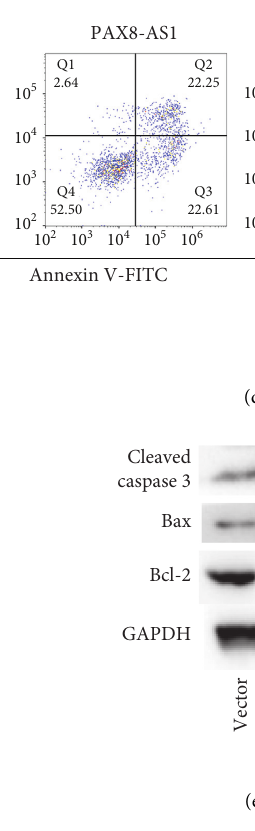
Figure 6: Interference with PKN2 reverses the effect of overexpression of PAX8-AS1 on cell proliferation and apoptosis. Note. (a) The expression of PKN2 in PTC K1 cells in vector, PAX8-AS1, and PAX8-AS1+sh-PKN2 groups was detected by qRT-PCR and western blotting; (b) the optical density values at 490nm at 24, 48, and 72 h in PTC K1 cells in the above three groups were detected by MTT assay; (c) cell proliferation of PTC K1 cells in the above three groups was examined by EdU assay; (d) flow cytometry was used to analyze the scatter patterns of cell cycle distribution of K1 cells in the above three groups; (e) the protein bands of apoptosis-related proteins in K1 cells in the above three groups were detected by western blot. ∗ P < 0 . 05 , ∗∗ P < 0 . 01 , and ∗∗∗ P < 0 .